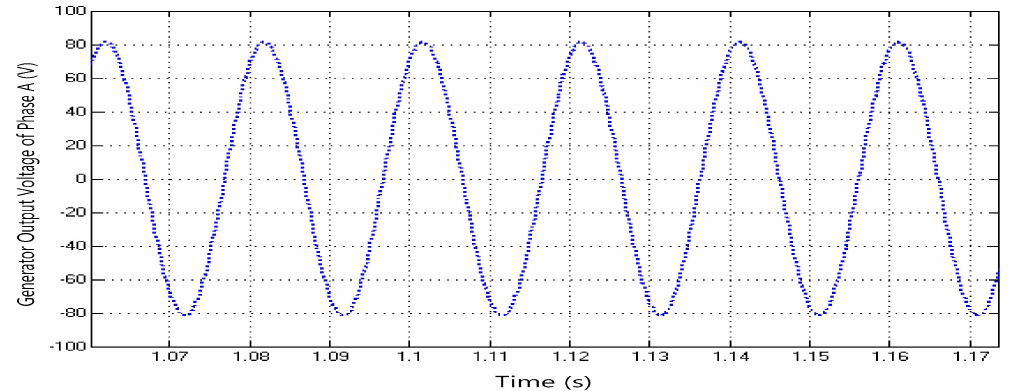
Figure 11. The waveform of generator output voltage of Phase (A).